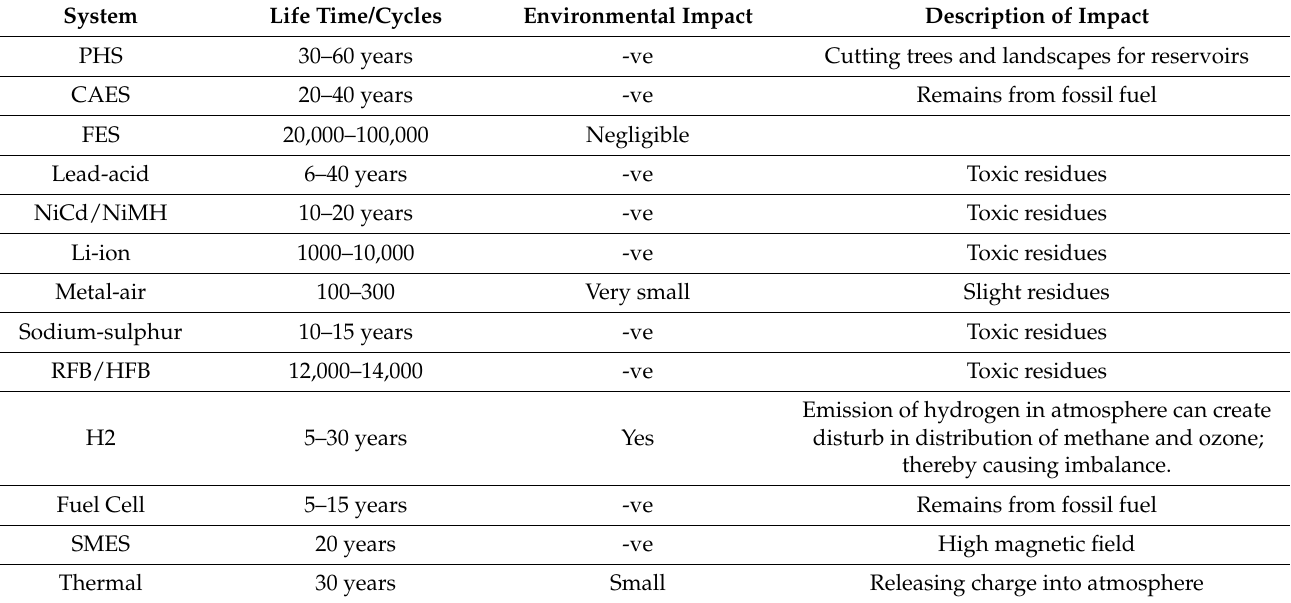
Table 6. Comparison of EES Systems in terms environmental impact